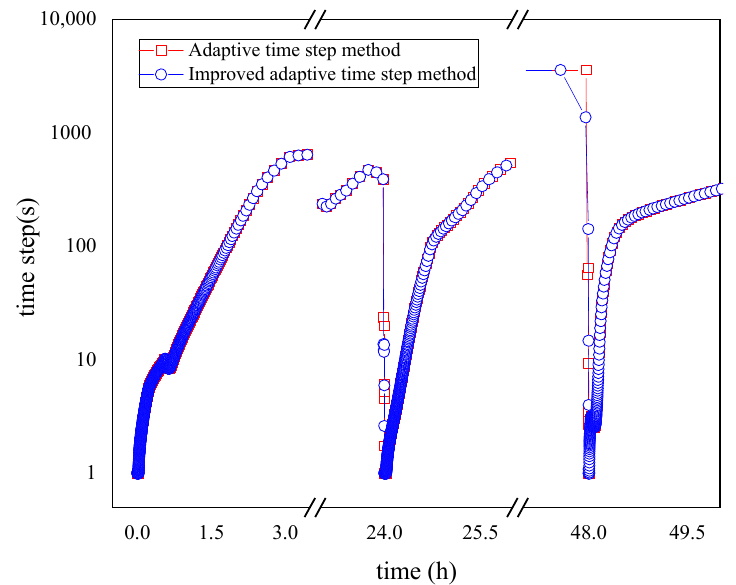
( c ) Figure 3. The result of the simulation. ( a ) The flow rate at the inlet; ( b ) The pressure at the outlet; ( c ) The temperature at the outlet. Figure 3 clearly shows the parameter situation during the entire 72 h simulation. (1) All three methods can describe the changes in the network system. (2) The inlet flow rate, the inlet pressure, and the outlet temperature are all in good agreement with those of the adaptive method prosed by Wang. 4.1.3. The Effect The effect of the improved method was analyzed, and the results are shown in Figure 4. At the beginning of the simulation, the time step increased slowly from 1 s to 1000 s